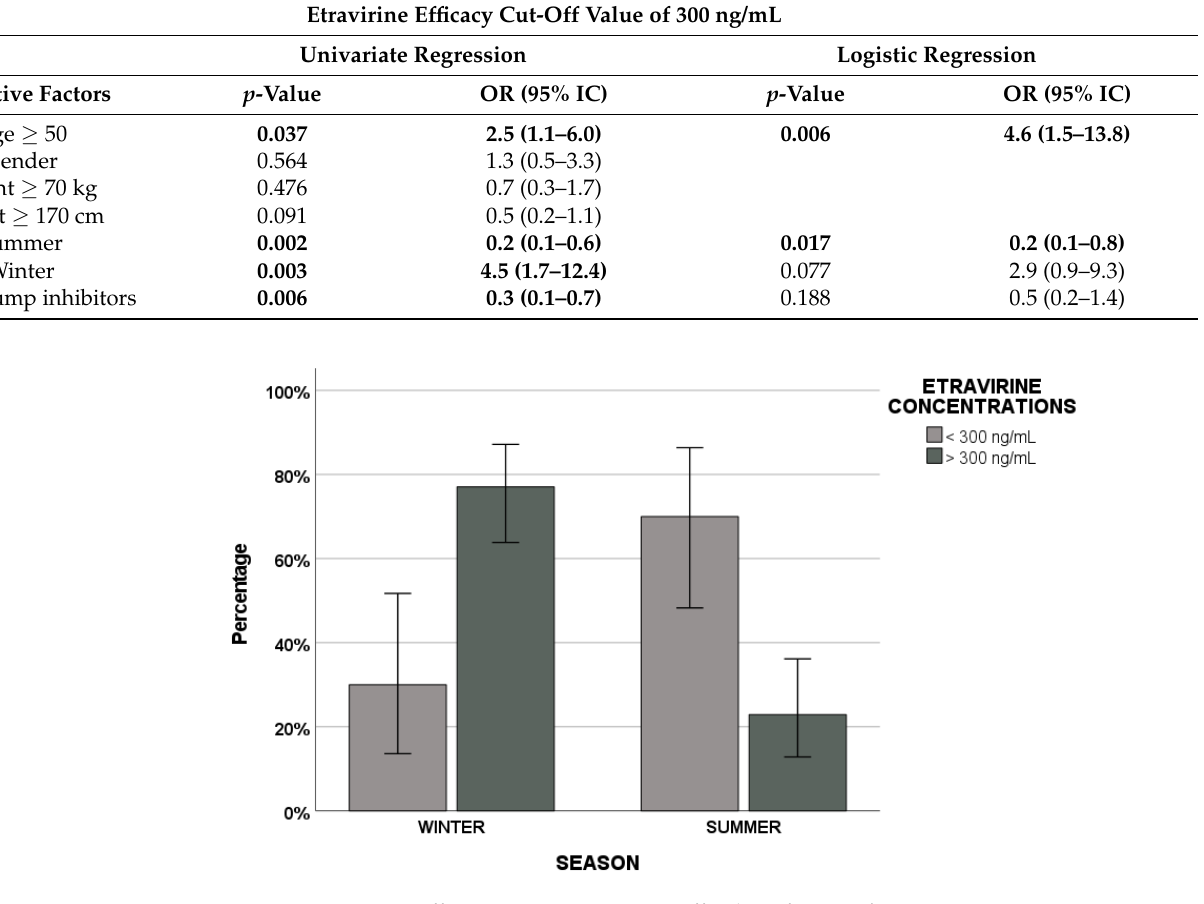
Figure 3. Etravirine efficacy concentration cut-off value of 300 ng/mL in summer vs. winter.